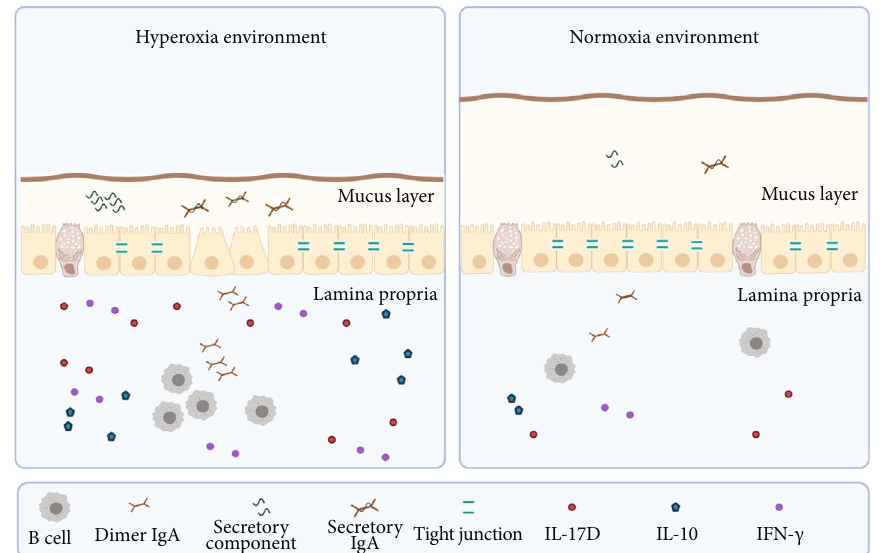
Figure 1: Injury of physical and immune barriers to hyperoxia therapy in neonates. During hyperoxia exposure, the number of goblet cells in the intestine decreased and the mucous layer damaged [10]. Moreover, it inhibits the expression of TJ between cells and increases intestinal permeability [10 – 12]. In the immune barrier, high oxygen increased SIgA content in the mucus layer by stimulating the SC expression [16, 25]. In addition, high oxygen also increases IL-17D, IL-10, and IFN- γ , resulting in a disturbance of cytokine levels [12,